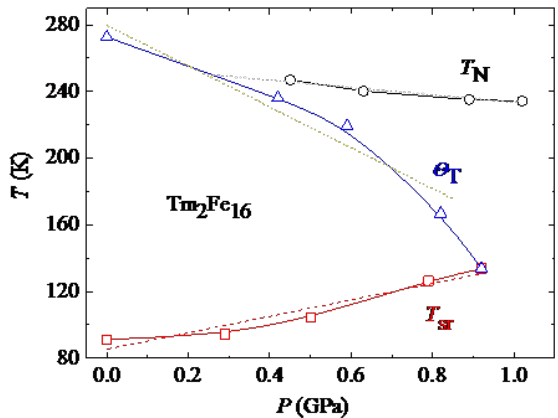
Fig. 3. Pressure dependences of T N (o), Θ T (Δ) and T sr (□) of Tm 2 Fe 16 measured at 0.01 T. T C (Δ) under P = 0 GPa. The dashed lines are the linear fits of the dependences.